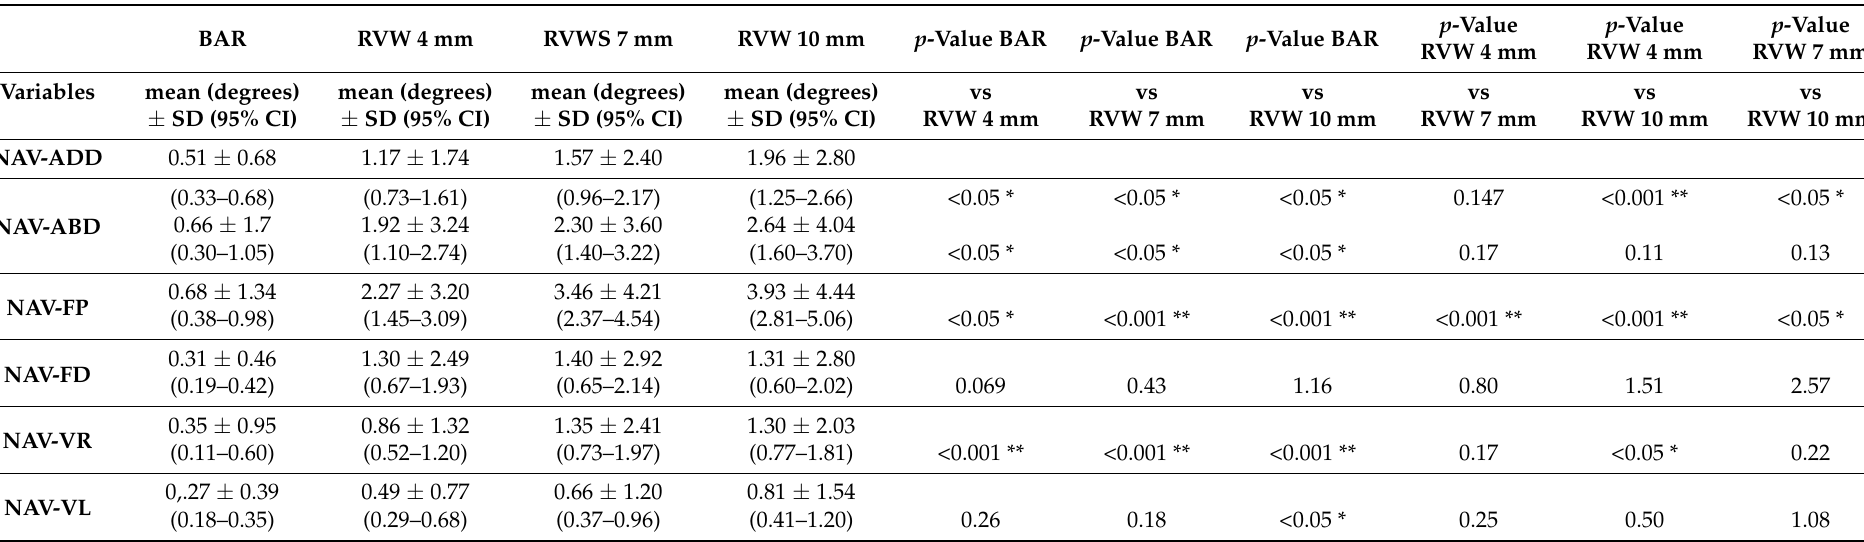
Table 5. The navicular sensor degrees of motion results in barefoot condition and with 4 mm, 7 mm, and 10 mm rearfoot varus